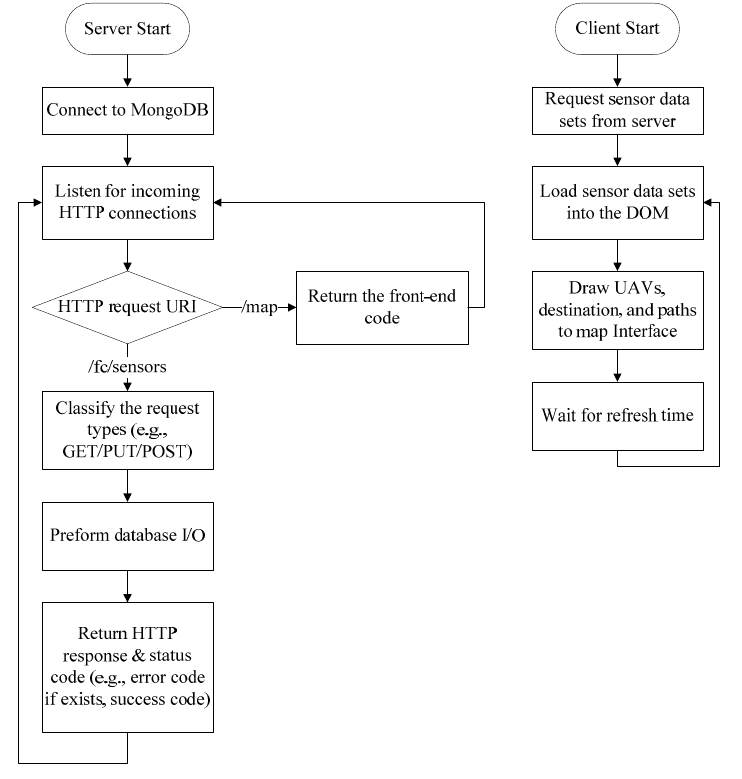
Figure 6. Flowchart for server and client.